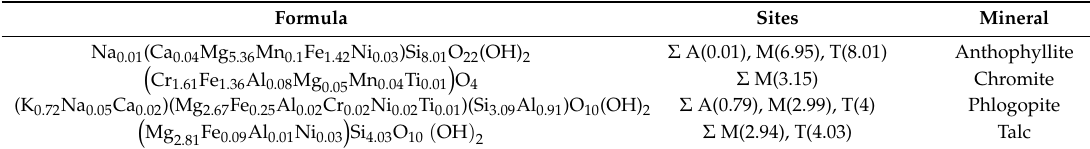
Table 1. The average mineral compositions from the talc zone (see Figure 6a).